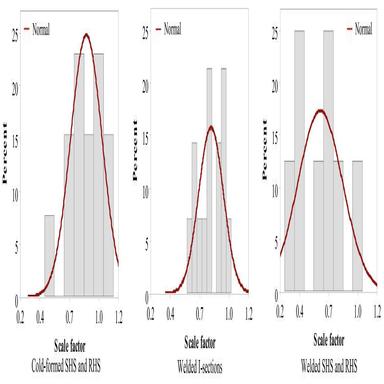
Histograms of residual stress magnitude scale factors for different stainless steel section types.